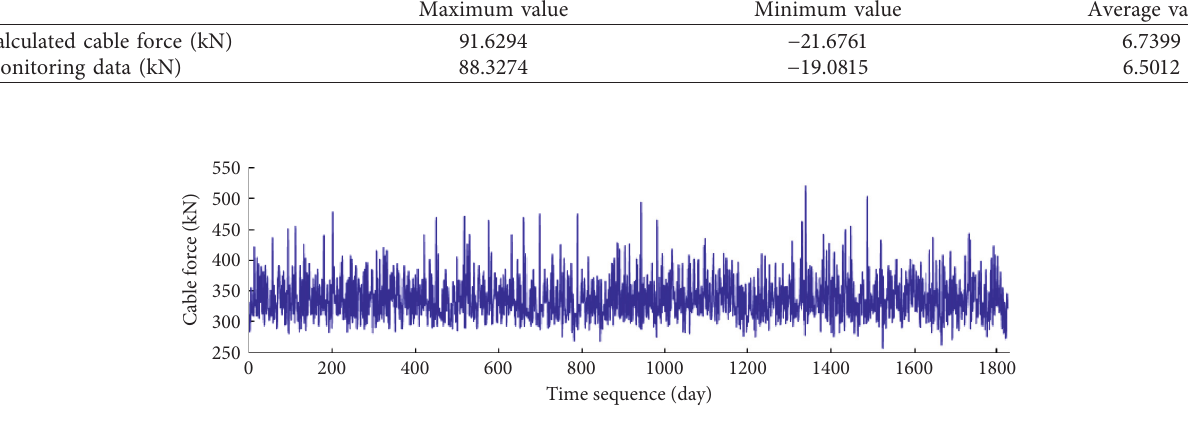
Figure 15: Five-year vehicle-induced daily simulated maximum cable forces.